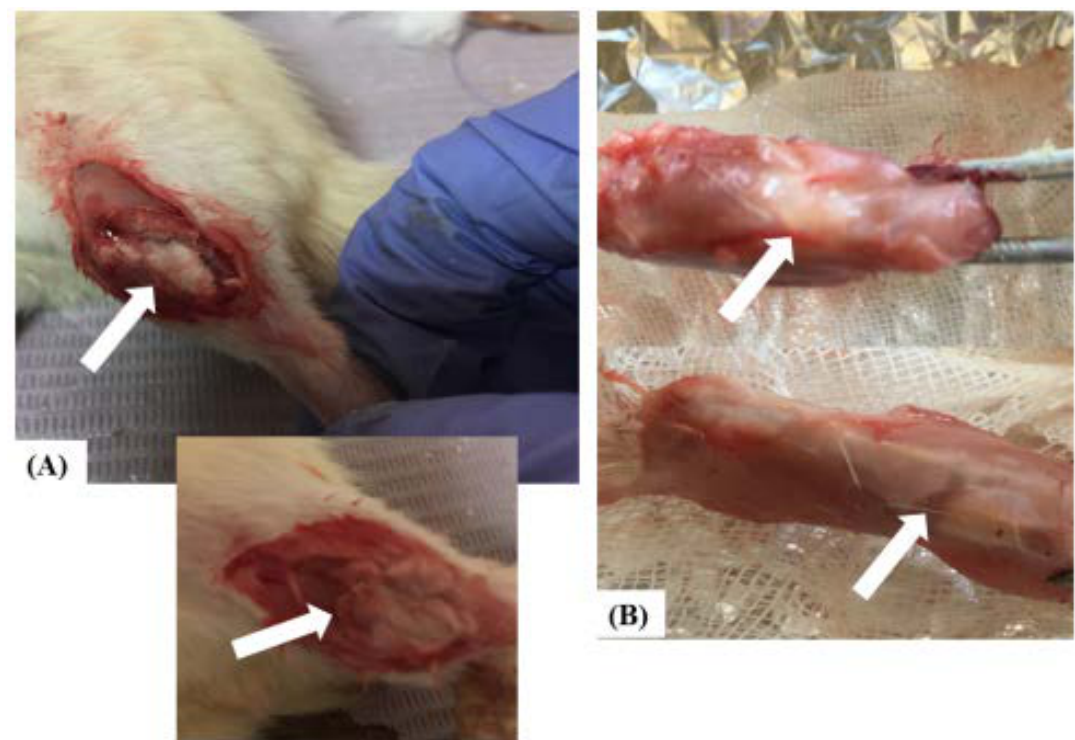
Figure 1. The surgical procedures that involved the application of three different formulations of MgS nanopowders at the site of fractures in the tibias of rats of different experimental groups: ( A ) Surgical procedure and implantation of different MgS nanopowders; ( B ) Macroscopic examination of post-operative healed bones. The white arrows in the images refer to either the site of fracture or healing in ( A ) and ( B ), respectively.